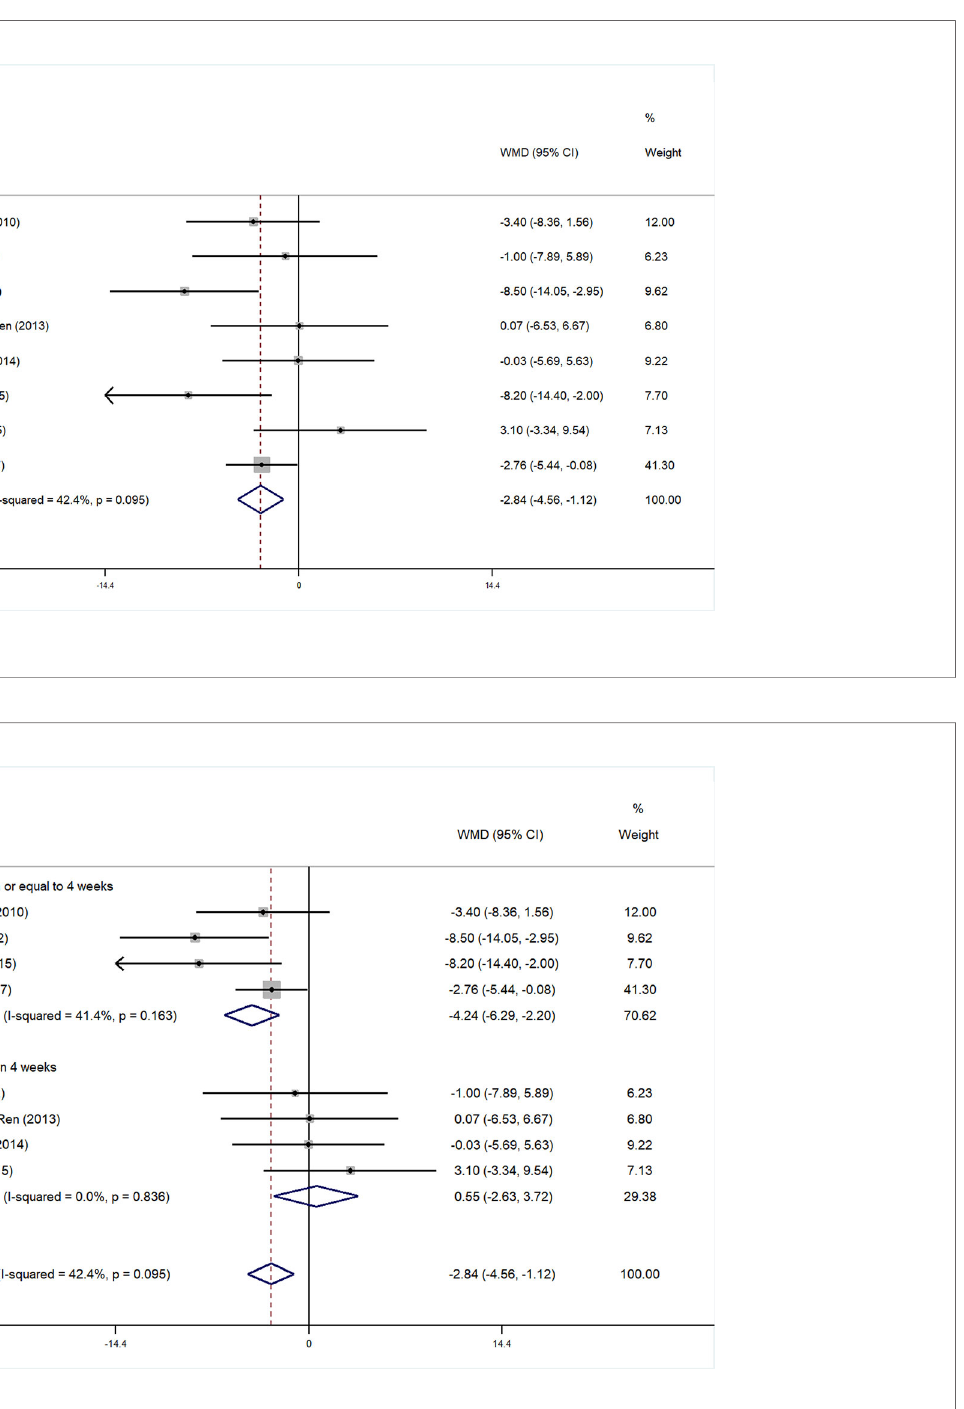
FIGURE 7 | Subgroup analysis of